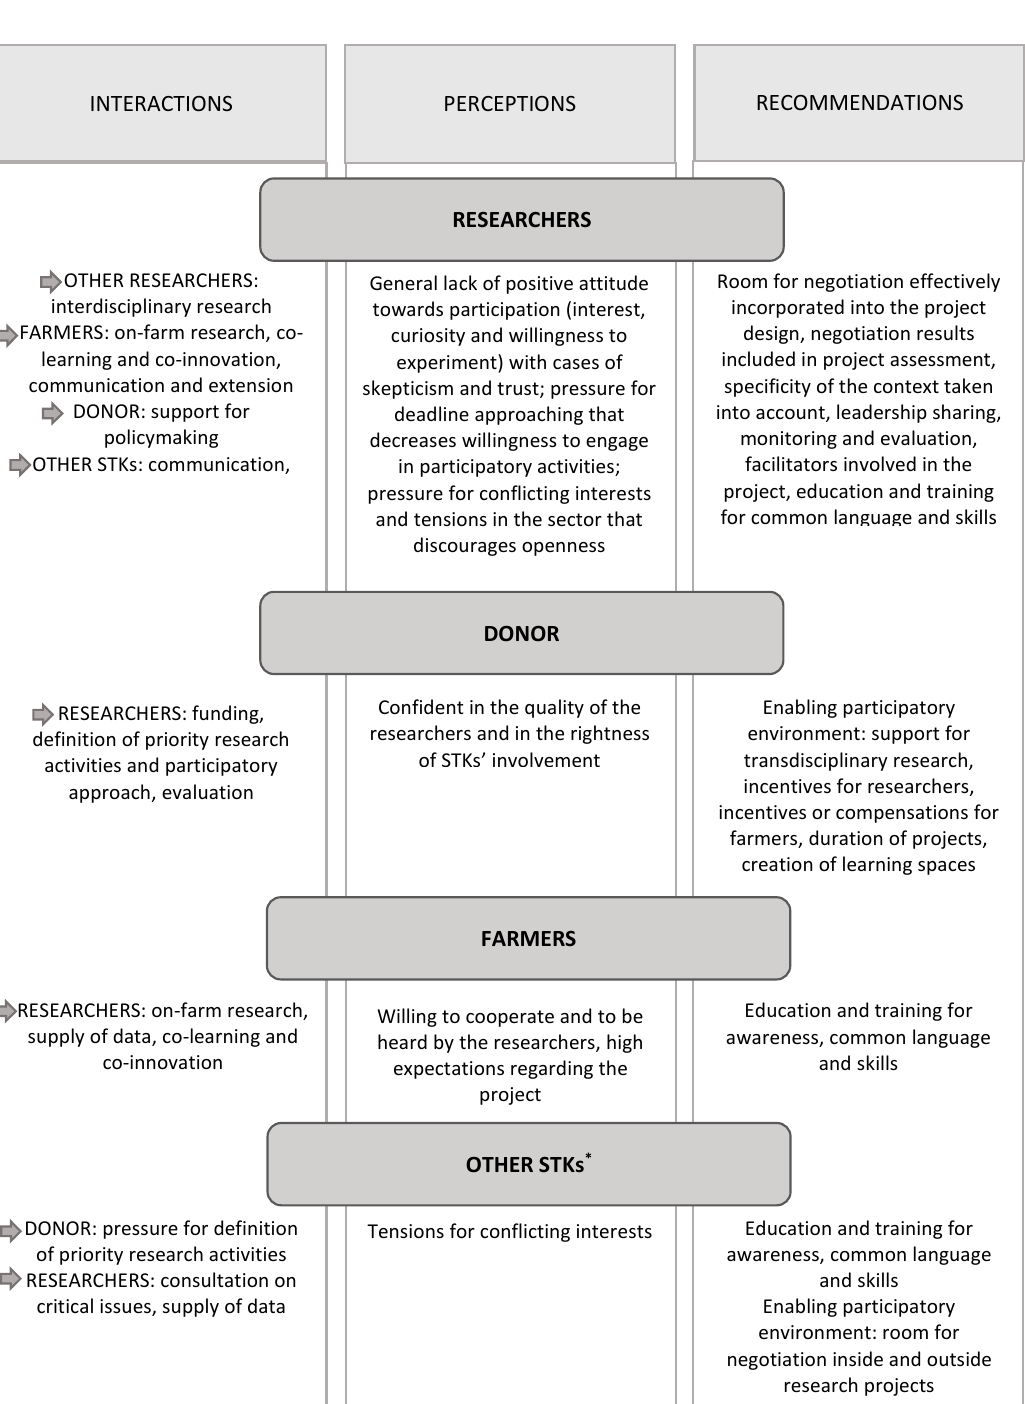
Figure 1. Interactions and perceptions of the actors involved in the case study and resulting recommendations. * STKs, stakeholders.